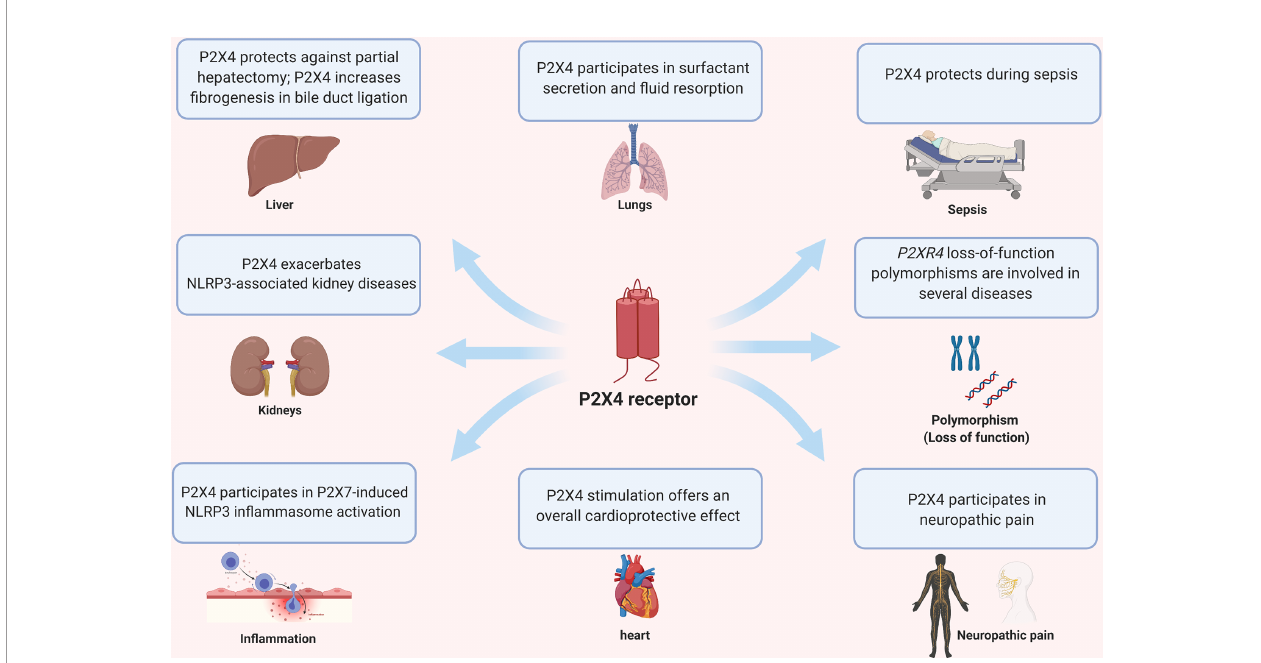
FIGURE 3 | Pleiotropic effects of P2X4 on different organs and